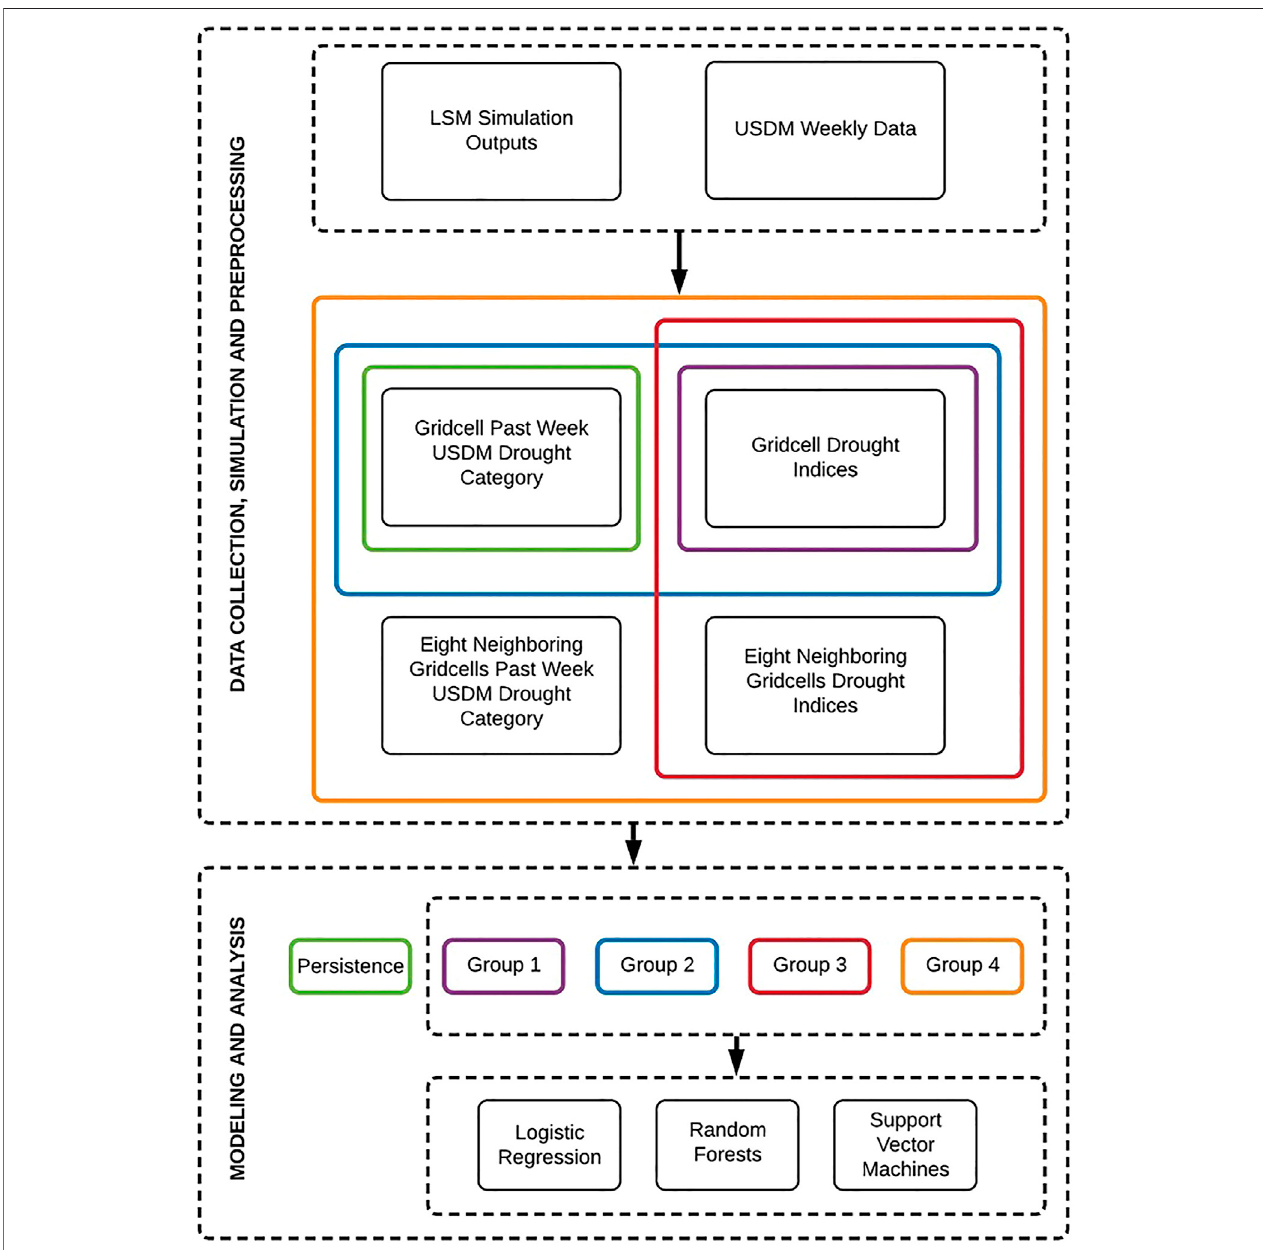
FIGURE 1 | Flowchart of the proposed framework for USDM drought categories prediction.